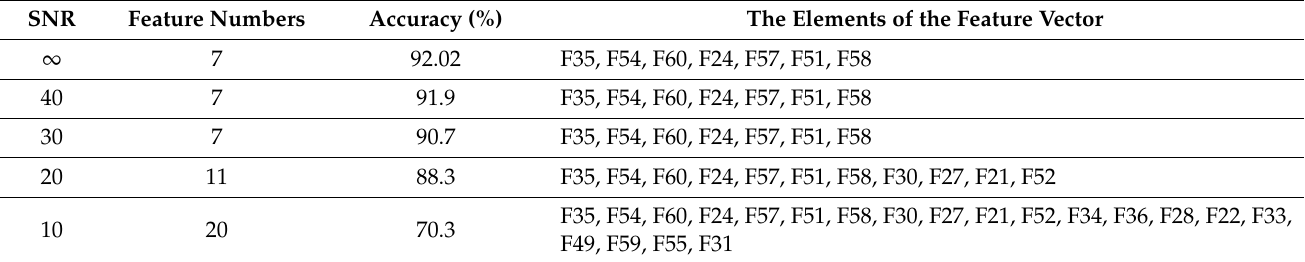
Table 6. Result of the MRA–CFS.